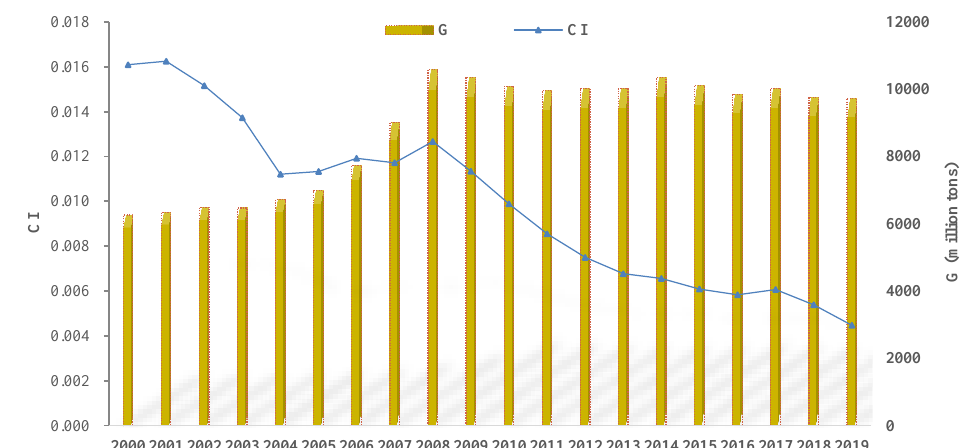
Figure 2. Changes of the total agricultural carbon emissions and agricultural GHG emissions intensity in the Main Stream of the Yellow River Basin in Gansu section from 2000 to 2019. “G” represents the total GHG emissions and “CI” represents the intensity of agricultural GHG in Figure 2. It shows the relationship of change between total carbon emissions and economic development.